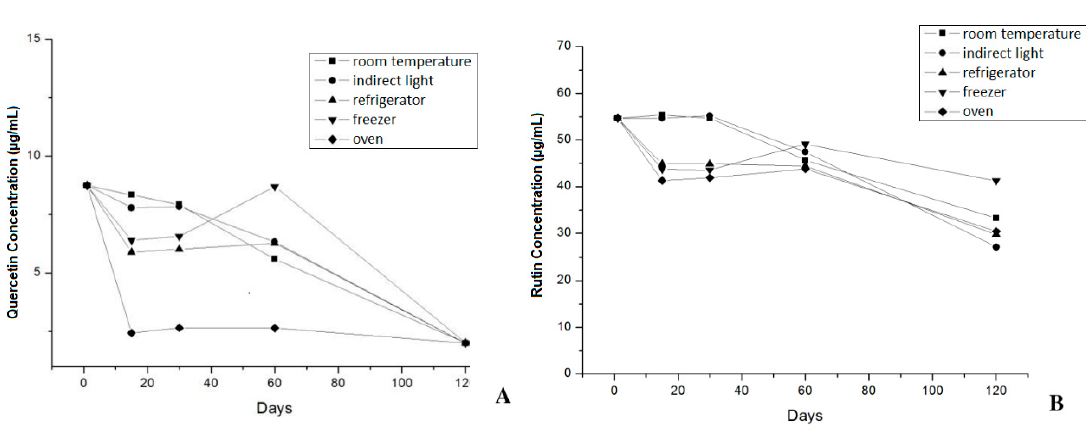
Table 2. Texture analysis of plain emulsion (without plant extract) and phytocosmetic (emulsion with the blend of plant extract).